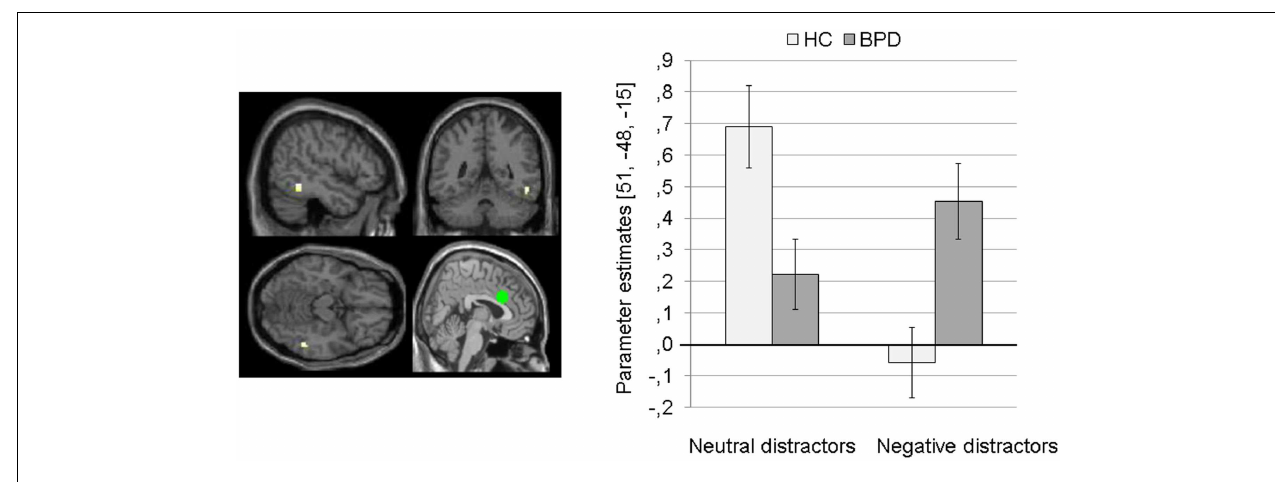
FIGURE 6 | Means ± standard errors of the mean (SEM) of parameter estimates for connectivity of the bilateral dorsal anterior cingulate (dACC) seed (depicted in green) with right superior temporal gyrus (MNI: